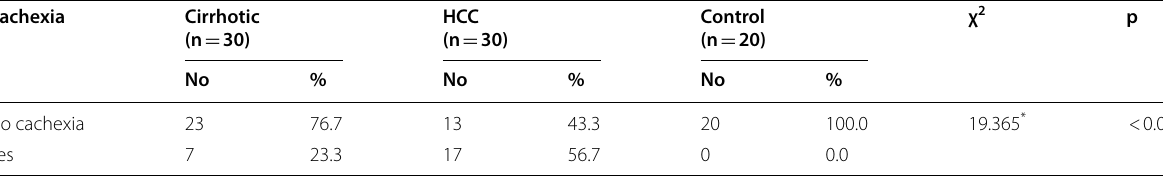
Table 2 Comparison between the three studied groups according to cachexia